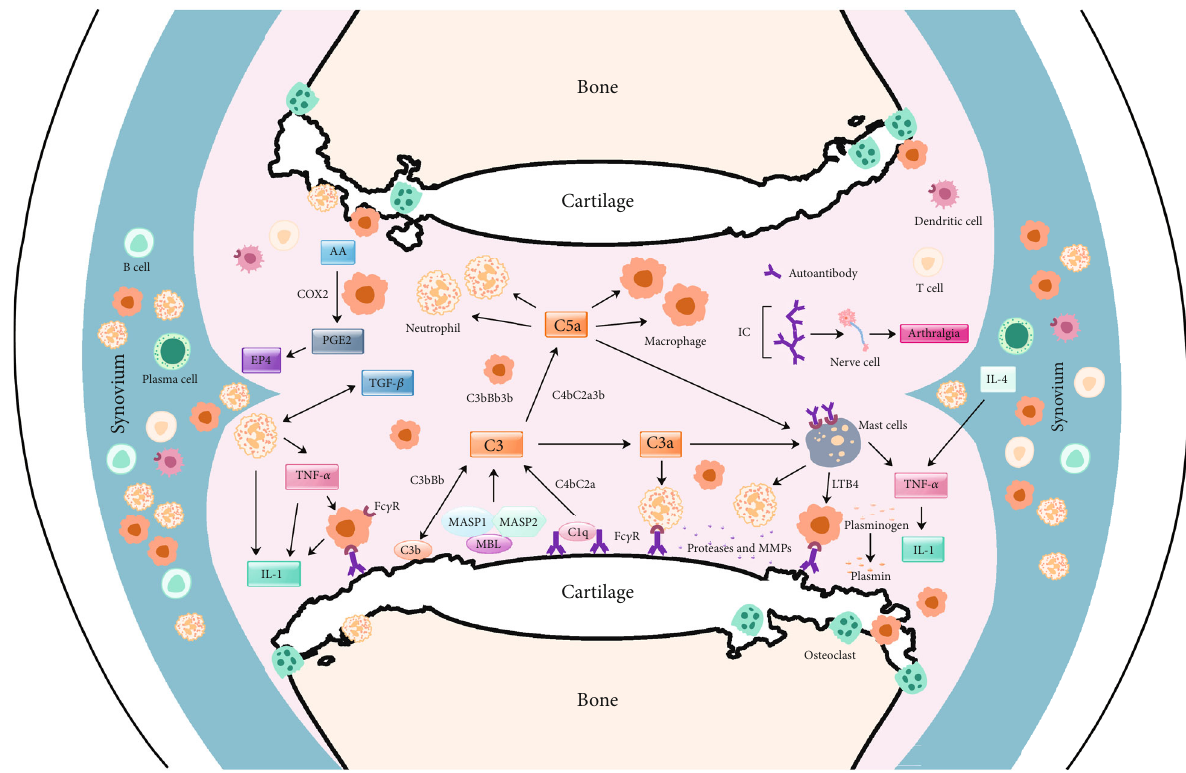
Figure 2: Likely interactions of molecules and factors in the antibody mediated joint in fl ammation. Upon binding to joint antigens or deposited as immune complexes on the cartilage surface, autoantibodies initiate in fl ammation-dependent and in fl ammation-independent activities, which culminate in the direct damage to the cartilage and bone. Activation of complement cascades by autoantibodies leads to the release of anaphylatoxins (C3a, C5a), attracting FcR-bearing immune cells to the in fl ammation foci, which in turn get more activated and secrete cytokines that can further activate resident nonimmune cells in the joint. All these cells in the in fl amed joint secrete more in fl ammatory mediators and extracellular matrix lysing enzymes that could destroy the cartilage and bone. AA: arachidonic acid; C1q, C2a, C3, C3a, C4b and C5a and B (factor B): complement components; CCL3: chemokine (C-C motif) ligand 3; COX2: cyclooxygenase-2; EP4: prostaglandin receptor; MASP: mannose-associated serine protease; MBL: mannose-binding lectin; IC: immune complex; IL: interleukin; LTB4: leukotriene B4; Fc γ R: Fc gamma receptors; PGE2: prostaglandin E2; TGF: transforming growth factor; TNF: tumor necrosis